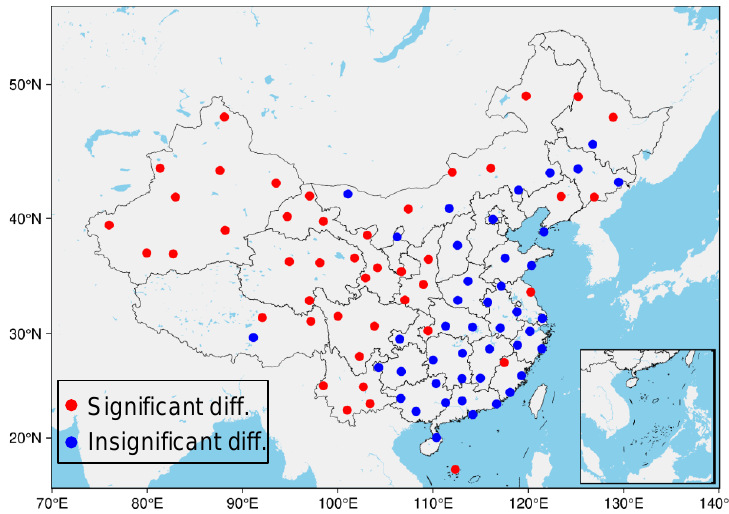
Figure 10. Stations with significant (red) and insignificant (blue) difference between the rainy-day model and the rainless-day model. If the mean relative bias of T m between the rainy-day model and the rainless-day model is larger than 0.5% or the maximal relative bias of T m between them is larger than 1%, it is classified as significant difference, and if not, it is insignificant difference.